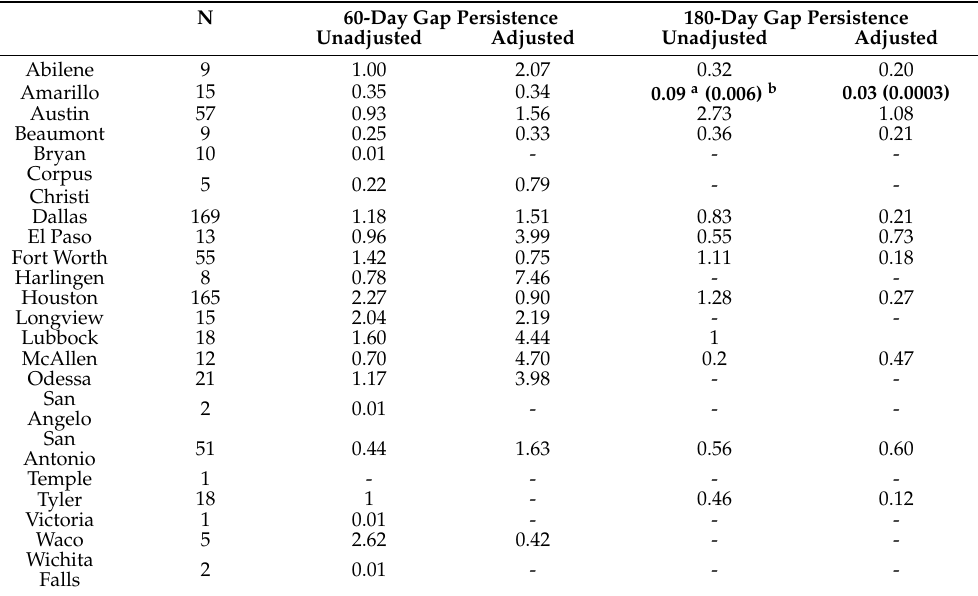
Table A2. Unadjusted and adjusted odds of receiving AHT by Hospital Referral Region (by different days of gaps in therapy).